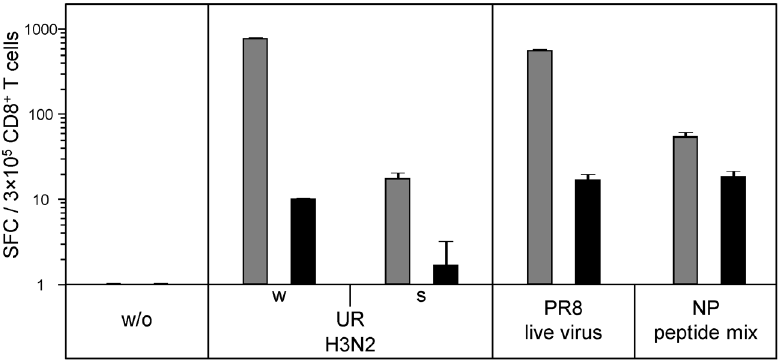
Figure 6. Proteasome inhibition strongly reduces CD8 + T-cell reactivity to whole virus vaccine. CD8 + T cells purified from PBMC of healthy donor HD21 were screened for IFN- c ELISpot reactivity to autologous immature DC loaded with seasonal A/H3N2-Uruguay whole virus or split virus vaccines, or an influenza A/H3N2 nucleoprotein oligopeptide mix. Targets also included DC infected with live influenza virus of the Puerto Rico 8 lab strain. During loading or infection, respectively, DC were treated with epoxomicin (black columns) or DMSO solvent (grey columns), which both did not reduce cell viability in trypan blue staining. Data are representative of 3 experiments performed in different donors.